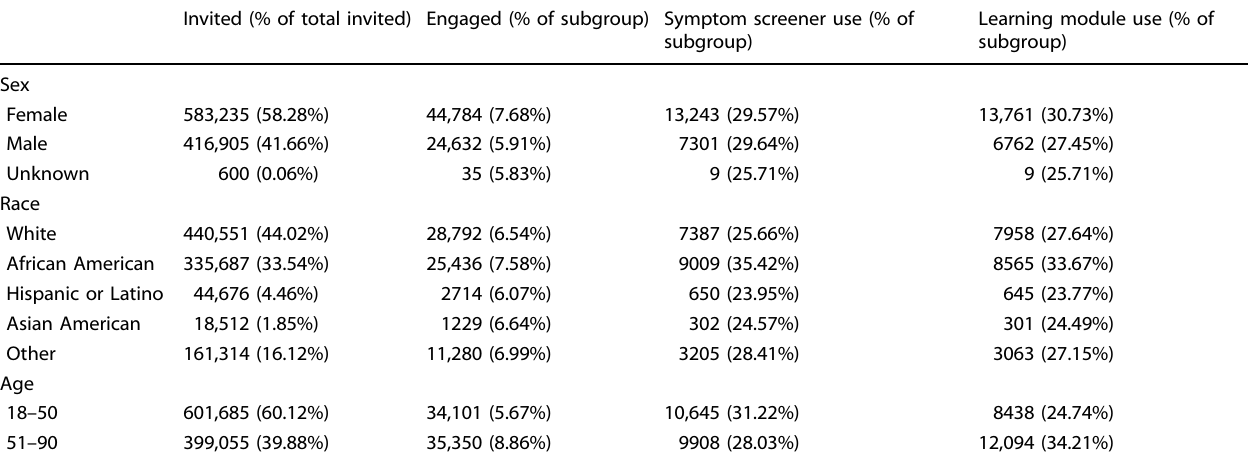
Table 1. Demographics of patients that were invited and used the chatbot with separation of module